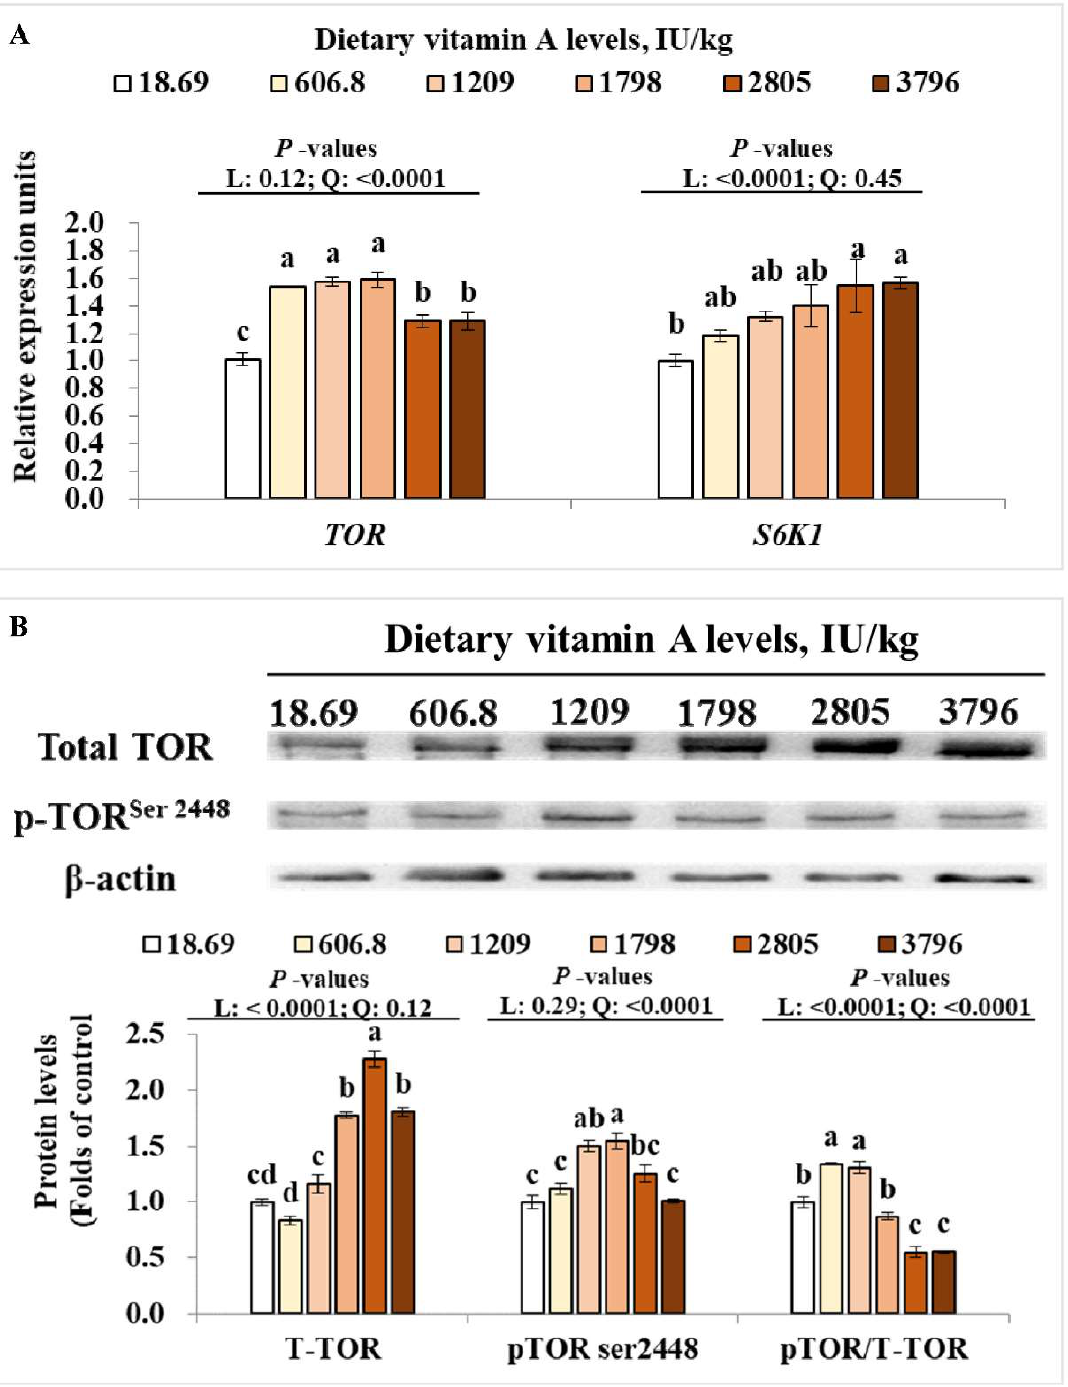
Figure 5. Effects of dietary vitamin A on relative mRNA levels of TOR and S6K1 ( A ), total and phosphorylation levels of TOR protein ( B ) in muscle of on-growing grass carp. Data are means ± SEM of three replicate groups, two fish for each replicate ( n = 3). a,b,c,d within a column, means without a common lowercase superscript differ ( p < 0.05). p -values underlined with a solid line indicate a linear and quadratic response to dietary vitamin A levels. SEM = standard error of the mean; L = linear; Q = quadratic; TOR = target of rapamycin; S6K1 = ribosomal protein s6 kinase polypeptide